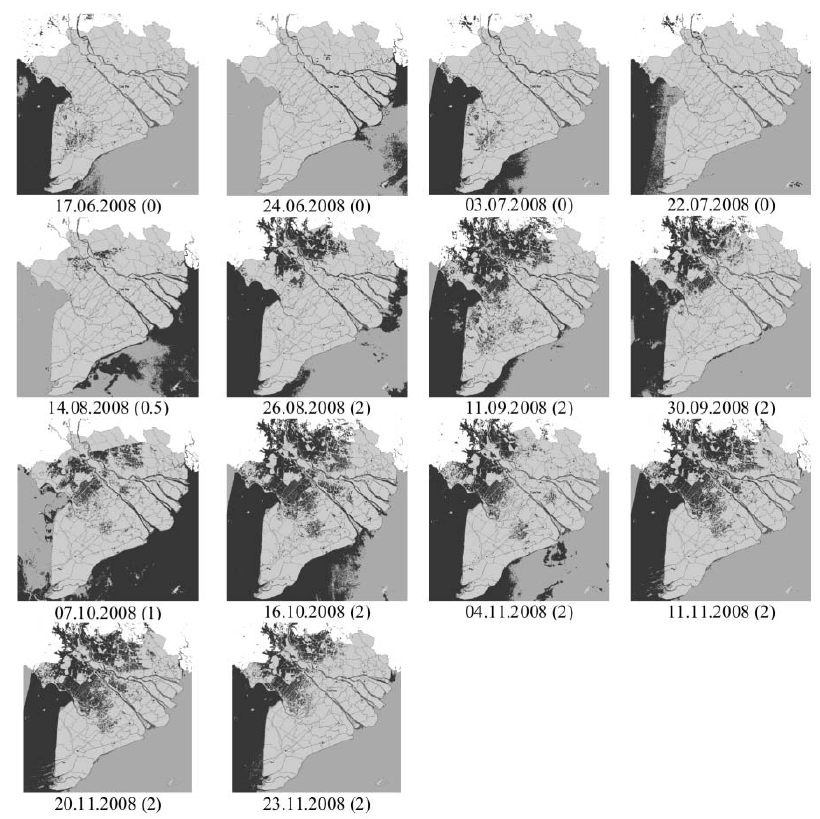
Fig. 2. Flood extent maps derived from ASAR used for model calibration. The numbers in the brackets indicate the weights assigned for the individual map in the calibration process (cf. Sect.